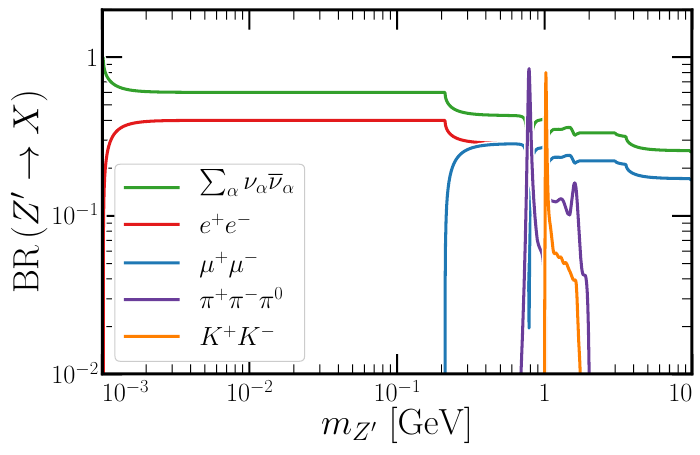
Figure 1 . Decay BRs of the Z 0 in U(1) B − L model into ν ¯ ν , e + e − , µ + µ + and the dominant hadronic channels. Data are obtained using the code darkcast